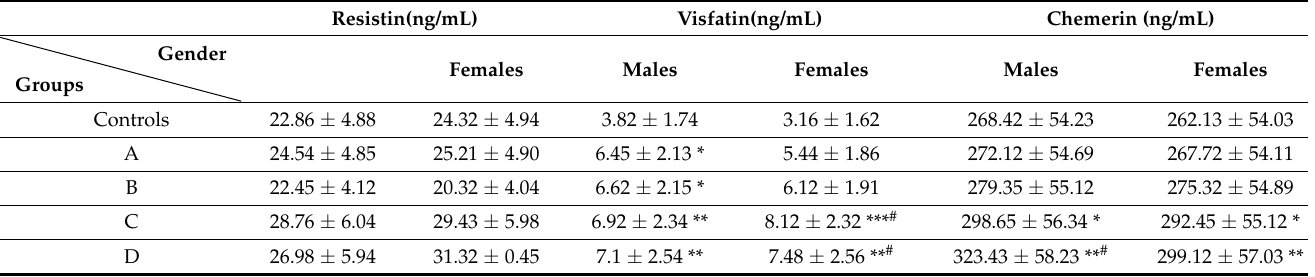
Group A—T2DM patients with normal body weight; group B—overweight T2DM patients; group C—T2DM patients with obesity and group D—T2DM patients with severe obesity. * p < 0.05 vs.